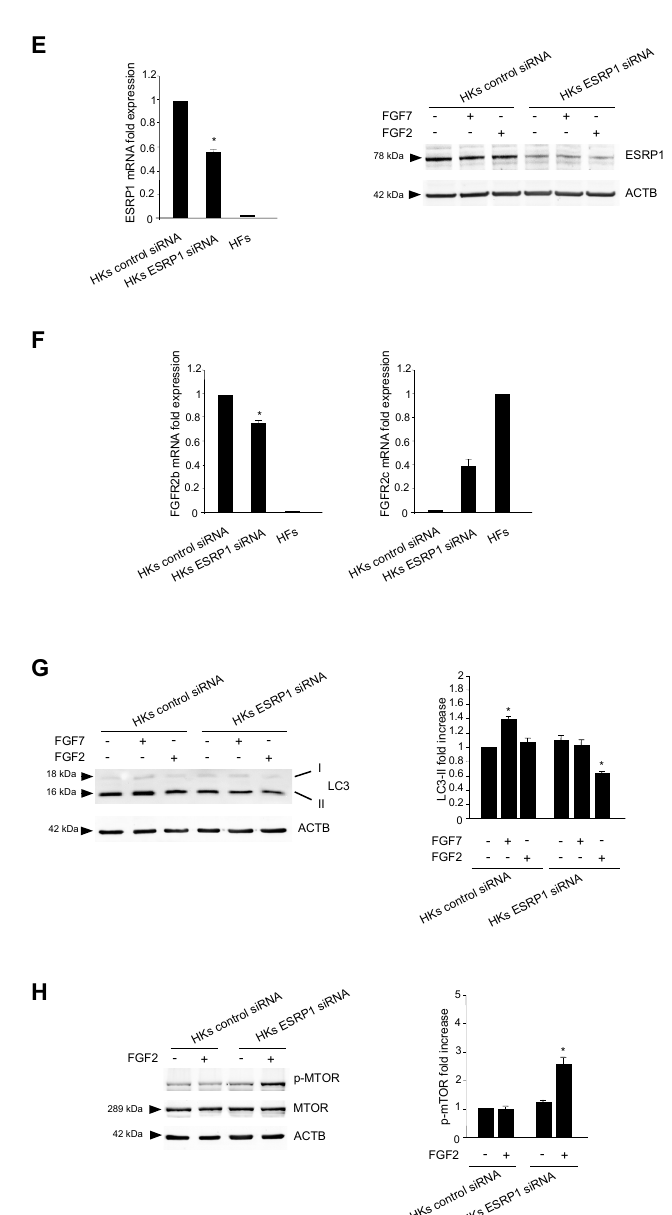
Figure 6. ESRP1 depletion by siRNA in haCaT cells results in aberrant FGFR2 splicing and FGF2-mediated inhibition of autophagy. ( A ) HaCaT cells were transiently transfected with ESRP1 siRNA or an unrelated siRNA as a control. Cells were then left in complete medium (left panel). Alternatively, cells were left untreated or stimulated with FGF7 or FGF2 in the presence or absence of the FGFR2 tyrosine kinase inhibitor SU5402 as above (right panel). Real-time RT-PCR analysis (left panel) and Western blot analysis (right panel) show the e ffi ciency of ESRP1 depletion. Results are expressed as mean values ± SE. The student’s t test was performed, and significance levels are defined as P values of ± 0.05. * p < 0.01 vs the corresponding control siRNA cells. For the Western blot analysis, equal loading was assessed with anti-ACTB antibody. ( B ) HaCaT cells were transiently transfected with ESRP1 siRNA or an unrelated siRNA as a control and then left in complete medium. Real-time RT-PCR analysis shows that ESRP1 depletion leads to a significant decrease of FGFR2b expression (left panel) and to the appearance of FGFR2c (right panel). Results are expressed as mean values ± SE. The student’s t test was performed, and significance levels are defined as P values of 0.05. * p < 0.05